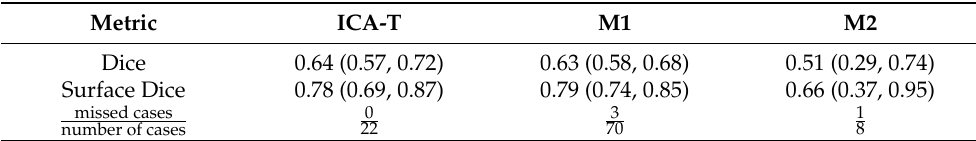
Table 3. Average Dice and surface Dice of weighted-sum per occlusion location. Numbers in the parenthesis show 95% confidence interval. Number of thrombi for each occlusion location in the test set is shown as ‘number of cases’ and the number of cases for each occlusion location with Dice = 0 is shown as ‘missed cases’.